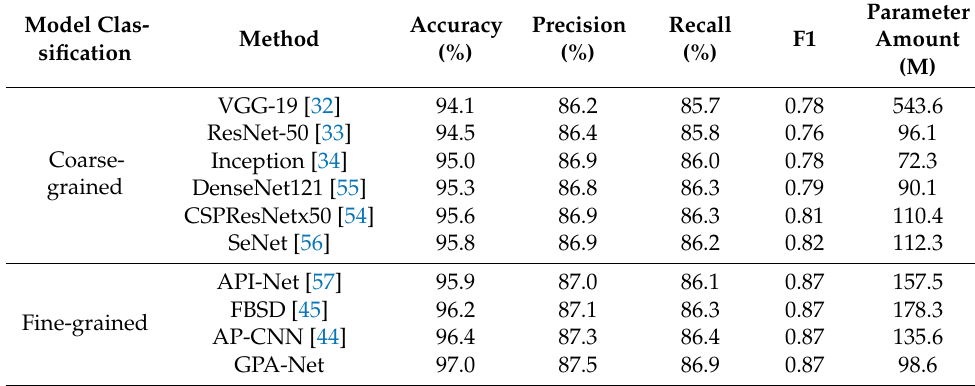
Table 2. Contrast performance on the AI Challenger dataset.